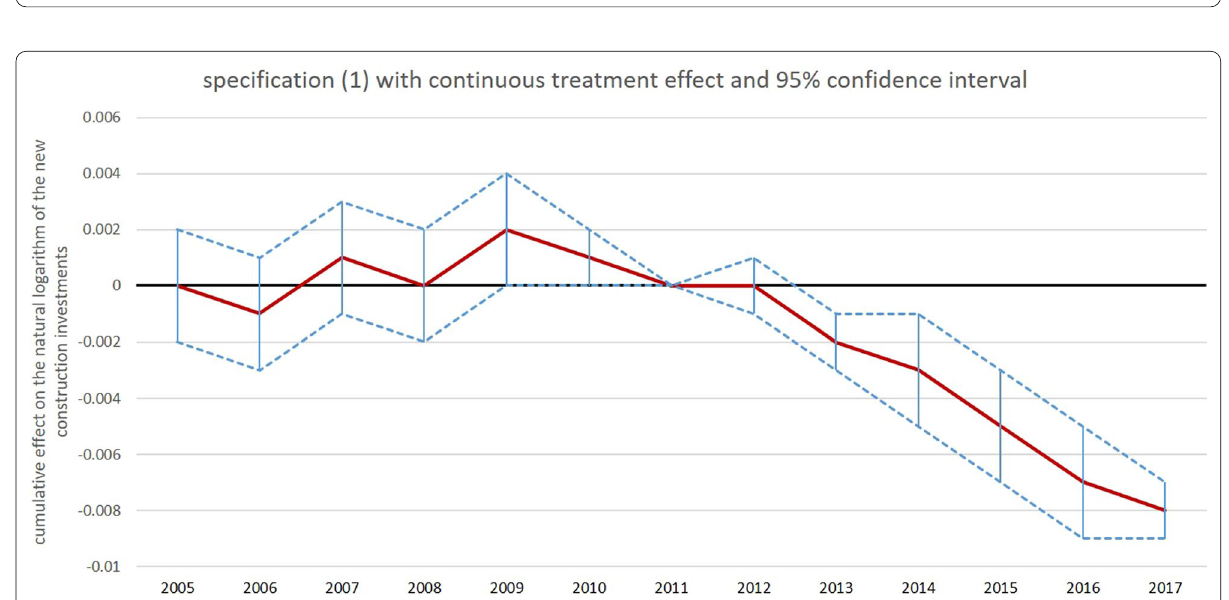
Fig. 4 Cumulative returns of the continuous treatment model before and after the second home law. Source : Author’s illustration of the obtained